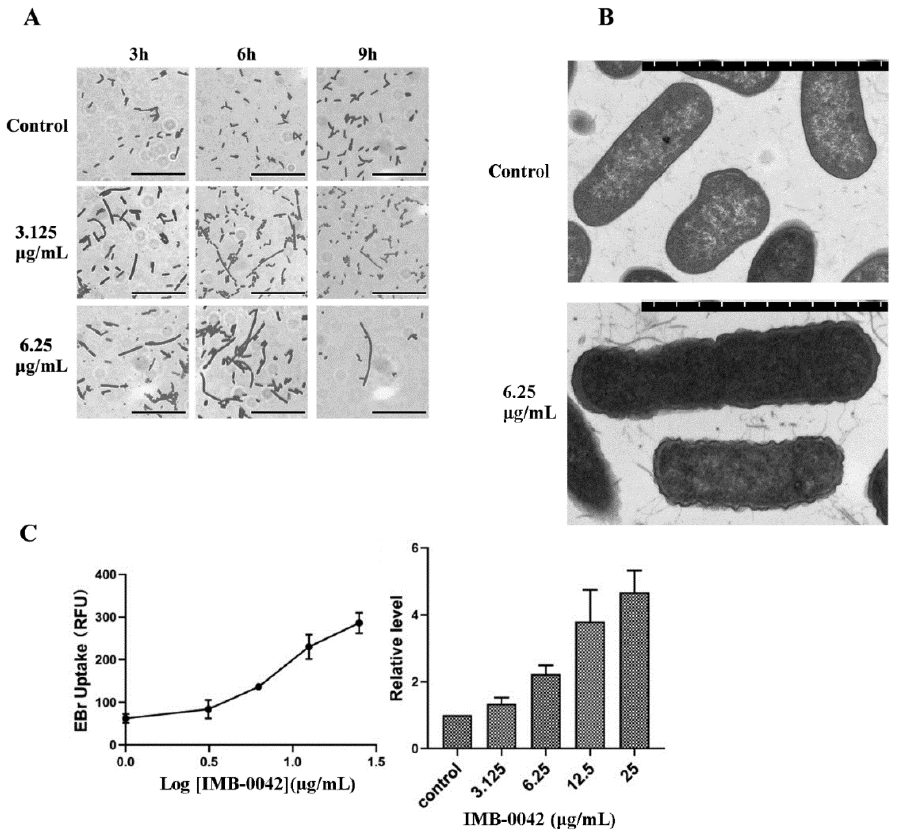
Figure 6. E. coli cells were treated with compound IMB-0042 at concentrations of 3.125 µ g/mL (1/8 MIC) and 6.25 µ g/mL (1/4 MIC) or DMSO, then collected every hour for morphological examination. ( A ) The morphological changes in E. coli cells, treated with IMB-0042, were seen under a light microscope. Scale bars, 5 µ m. ( B ) The morphological alterations in E. coli cells, treated with IMB-0042 for 12 h, were seen with a transmission electron microscope (TEM). Membrane constituents were accumulated, and multilayered membranous bodies were found in the periplasmic space in cells treated with compound IMB-0042. Scale bars, 0.5 µ m. ( C ) E. coli cells were treated with IMB-0042 (ranging from 3.125 µ g/mL to 12.5 µ g/mL) or DMSO (0.1%) for 12 h. EtBr was then added into the medium to a final concentration of 4 µ g/mL. The relative fluorescence intensity is shown.